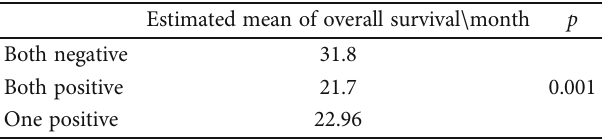
Table 7: OS analysis of studied cases according to MALAT-1 and BACH expression.